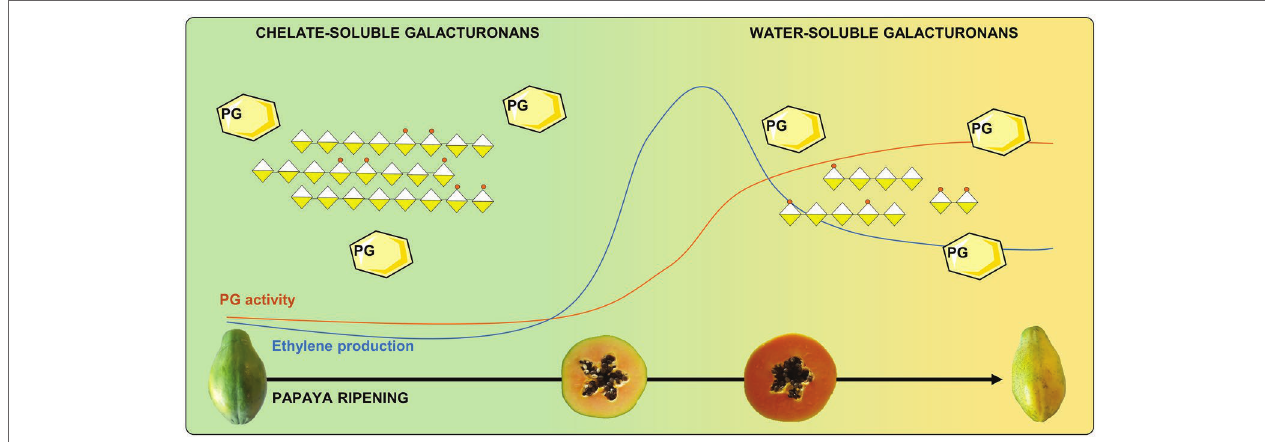
FIGURE 1 | Ethylene production and PG activity during papaya ripening: papaya pectin cell wall solubilization. Ethylene triggers PGs that massively solubilize high-molecular weight pectin by action in the non-methylated areas and releasing the low-molecular weight fractions that will be enriched in methylated fractions due to the lower activity of PME in ripe papayas. PG,